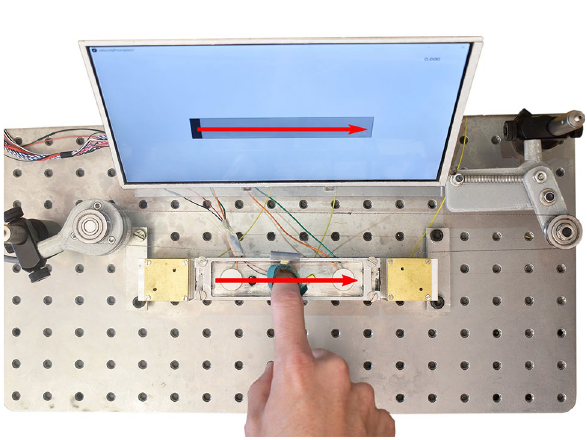
Figure 5. Presentation of the stimuli for the 4 gradient values (from top to bottom of the figure) under the 60 mm window condition with 3 types of measures. The left figures present the amplitude command of the modulating signal, the center present the measured vibration of the glass plate and the right present the measured friction coefficient between the finger and the surface. The amplitude is attenuated for higher frequencies to equalize the perceived intensity of the stimuli. Friction measurements are performed with a sensor described in a previous work 52 .